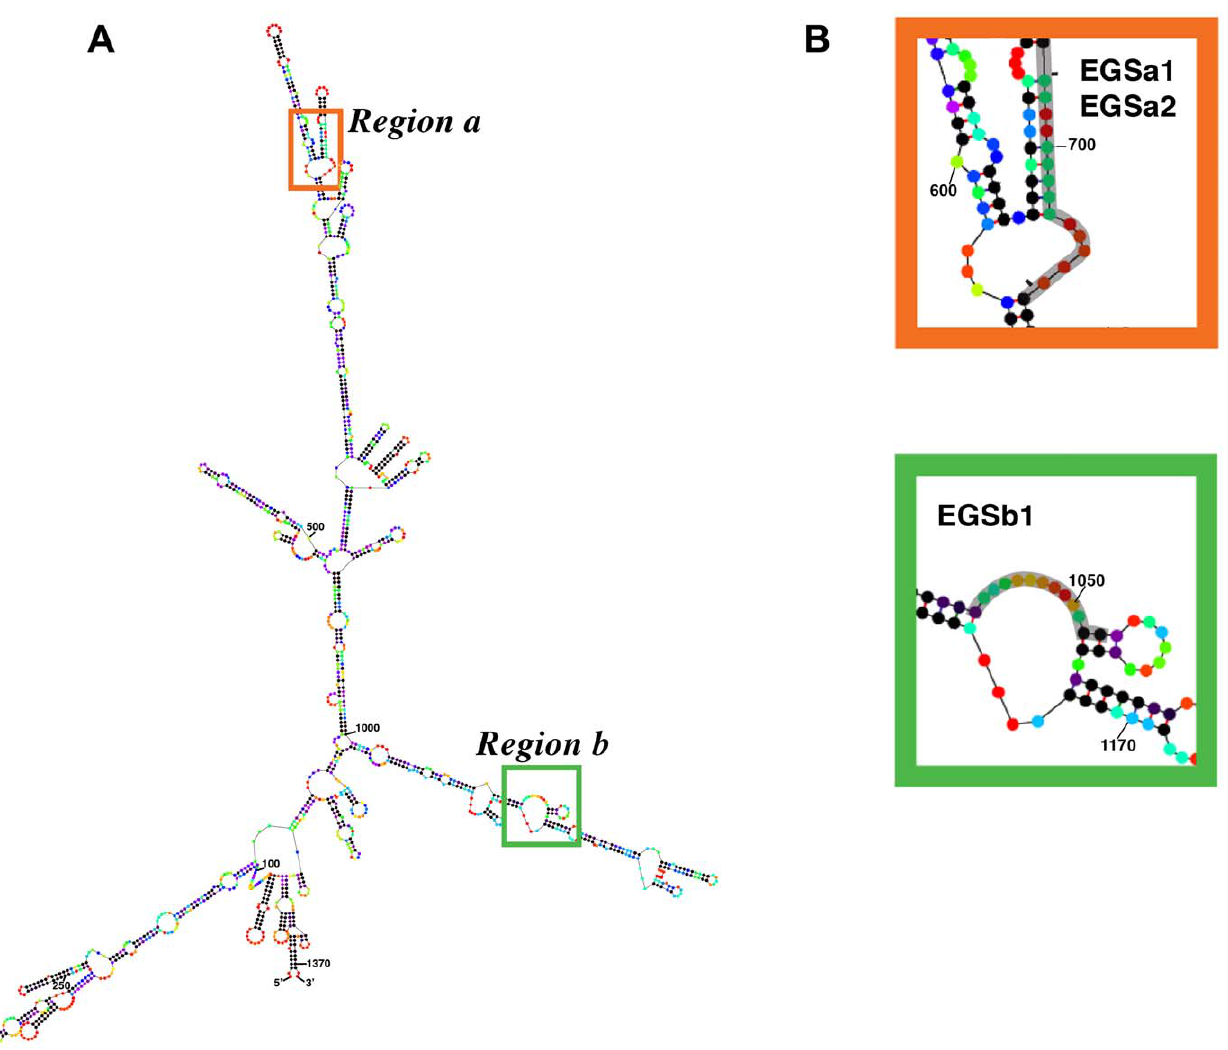
Figure 2. Secondary structure of ftsZ mRNA and regions targeted by EGSs. A. Secondary structure of the ftsZ mRNA (nucleotides 105083– 106456, accession number NC_000913.2) generated with m-fold software [34]. B. Zoom in the two regions selected as targets. Colors of the dots indicate the probability that they exist as single stranded. In decreasing order: red, orange, yellow, green, cyan, blue, violet and black. The sequences targeted by the EGSs are shown shadowed. EGSa2 includes an extra nucleotide at each end with respect to EGSa1, this is indicated by two short lines.